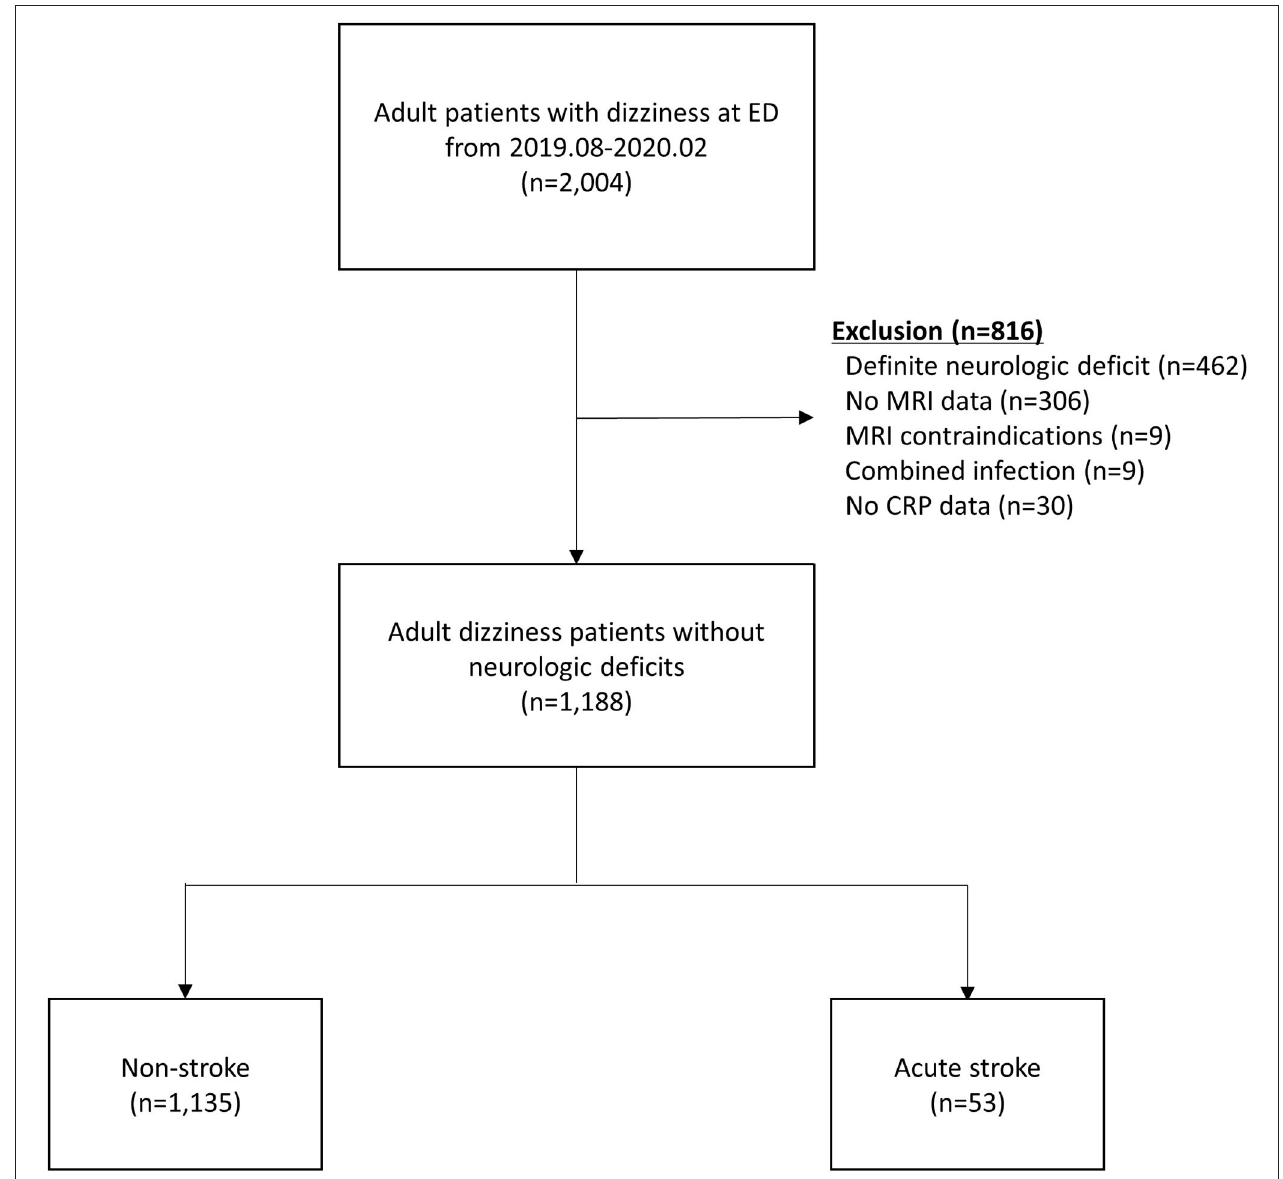
FIGURE 1 | Patient flow diagram. CRP, C-reactive protein; ED, emergency department; MRI, magnetic resonance imaging.